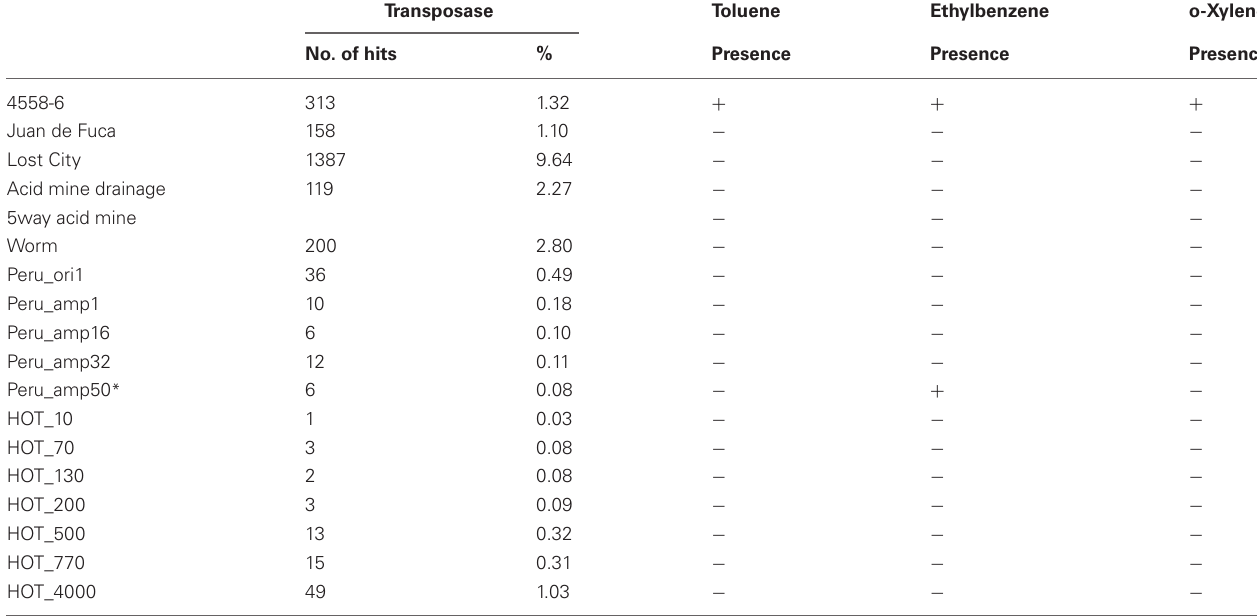
Table A3 | List of enzymes involved in hydrocarbon biodegradation in metagenomes from different environments, presence was marked with “ + ,” while absence with “ −